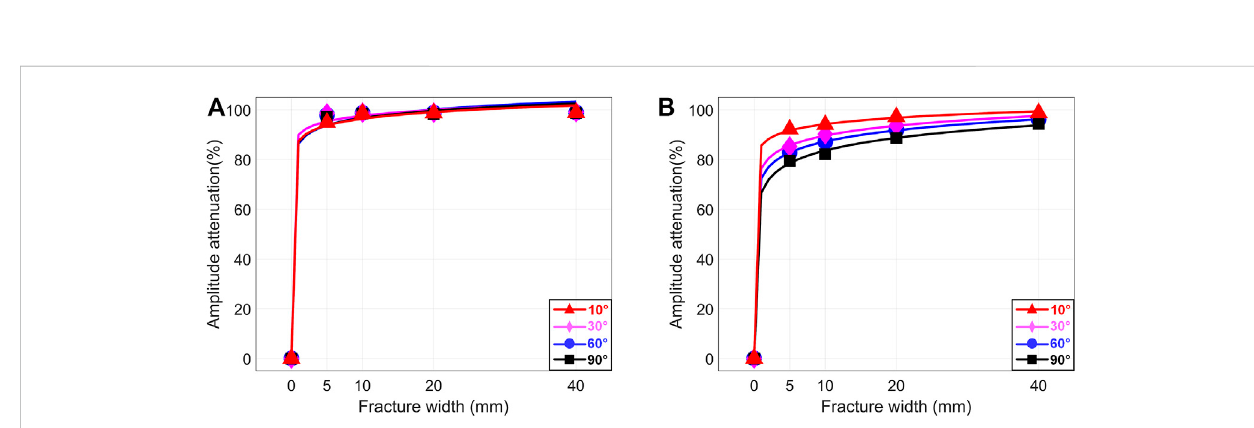
FIGURE 15 Amplitude attenuation of P- and S- waves versus different fracture widths and dip angles. The fracture is fi lled with gas. The fracture widths are 0, 5, 10, 20 and 40 mm. The fracture dip angles are 10 ° , 30 ° , 60 ° and 90 ° . (A) P wave; (B) S